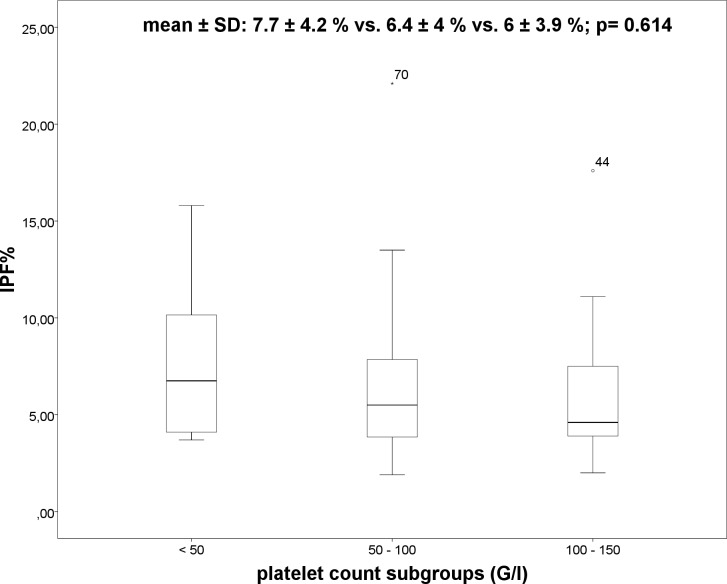
Boxplot: IPF% and the platelet count subgroups.